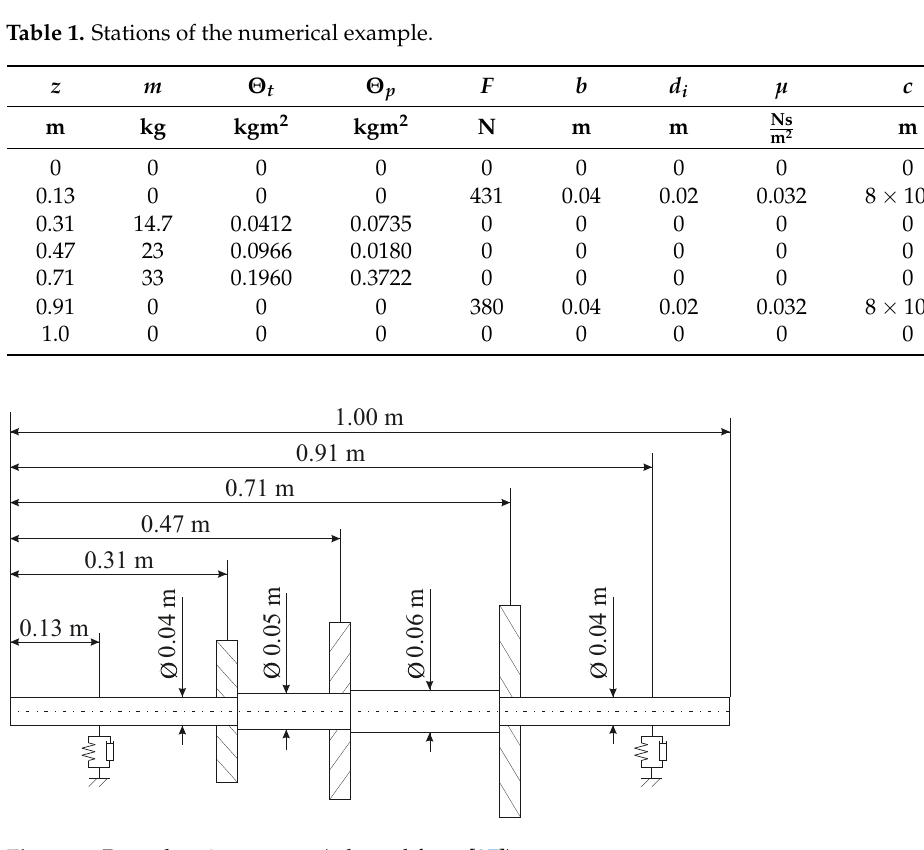
Figure 3. Rotor-bearing system (adapted from